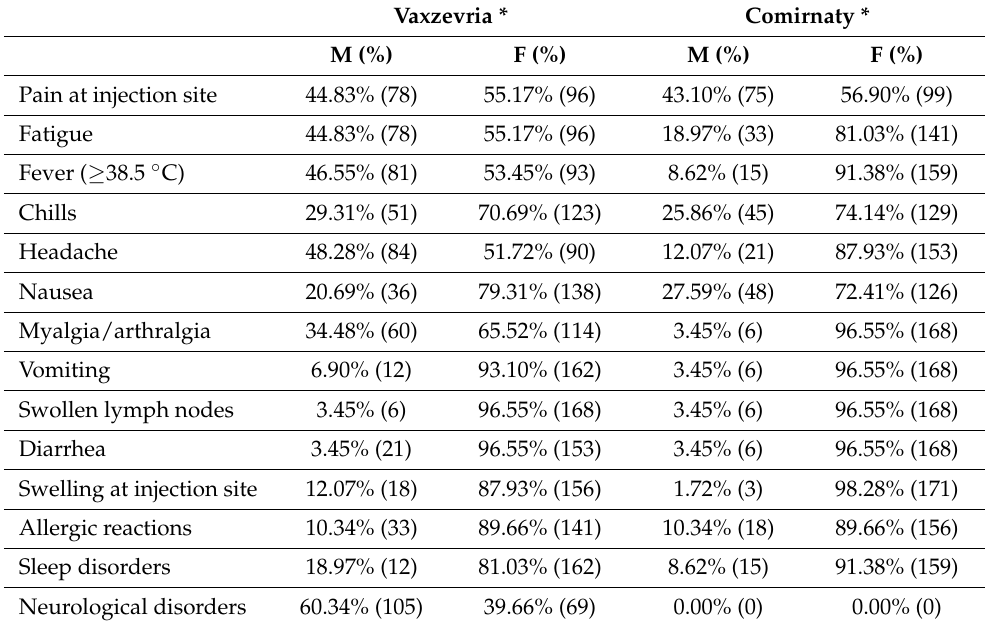
Table 3. Undesirable effects reported after the administration of Vaxzevria and after Comirnaty.